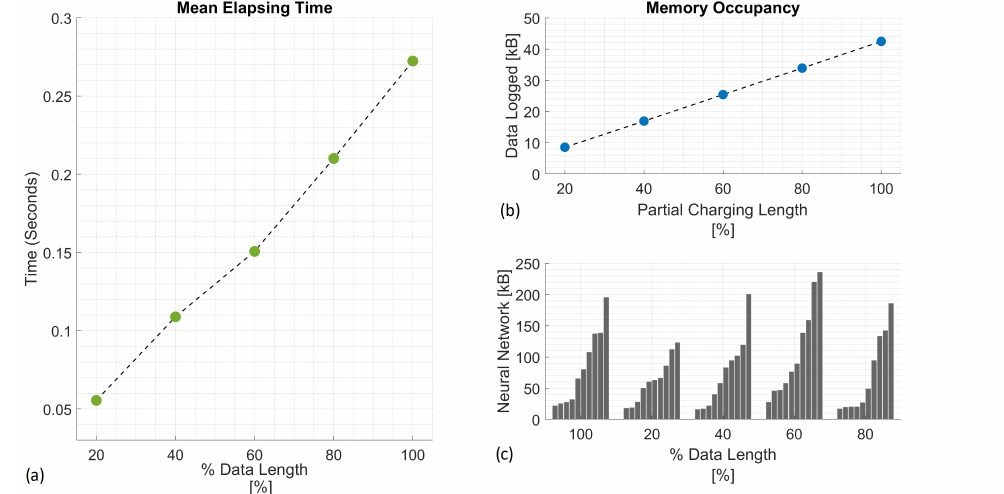
Figure 10. The plotted values are referred to the results shown in Analysis #1. ( a ) Time consumption during neural network prediction and depending on SOC window length. ( b ) Memory occupancy by logging data and depending on SOC window length. ( c ) Memory occupancy by Bi-LSTM networks and depending on SOC window